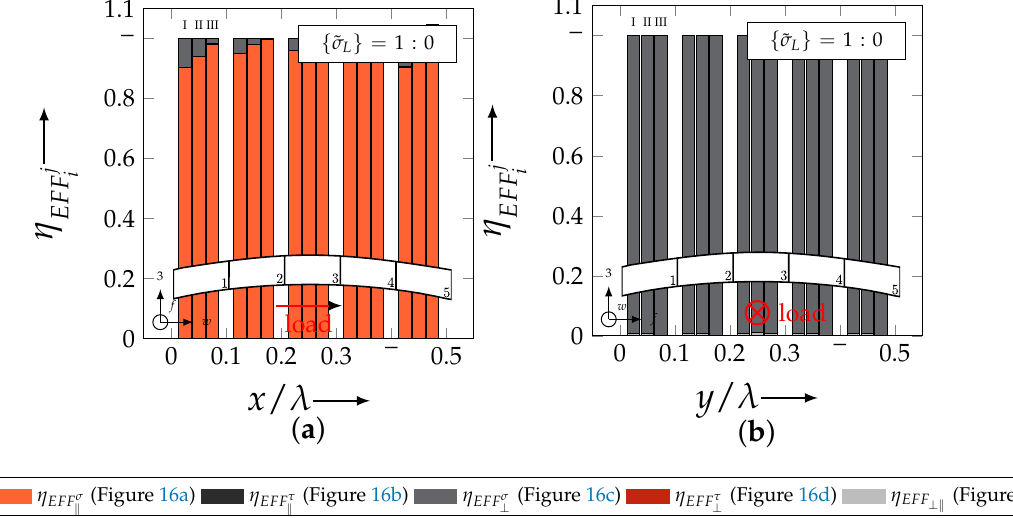
Figure 24. Illustration of the composition of FM by their fractions η the load path { ˜ σ L } = 1:0 for ( a ) weft and ( b ) fill